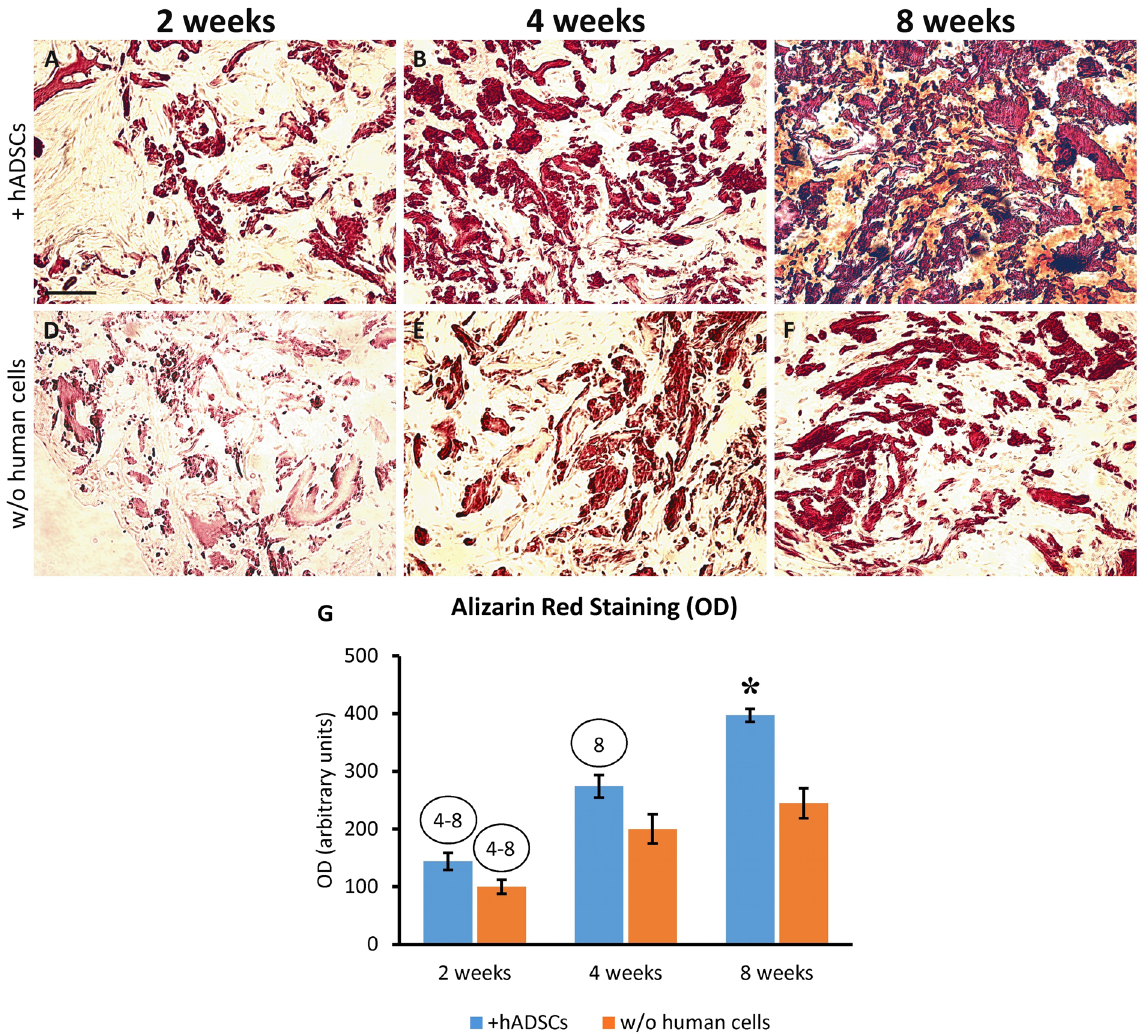
Figure 5. Alizarin Red S staining showing the time-course of mineralization within the scaffolds implanted either charged with hADSCs ( A – C ) or cell-free ( D – F ) and explanted at 2, 4 or 8 weeks after surgery. It is evident that the mineralization increased overtime in both treatment groups, but the addition of hADSCs determined a strong increase of this process. The graph ( G ) shows the quantitative evaluation of Alizarin Red staining by measuring the optical density (OD). The numbers into the circles indicate significant differences (P < 0.05) from the corresponding time-points, in weeks (same treatment groups), while the asterisk indicates significant difference (P < 0.05) from the other treatment group (same time-point). Scale bar: 100 μ